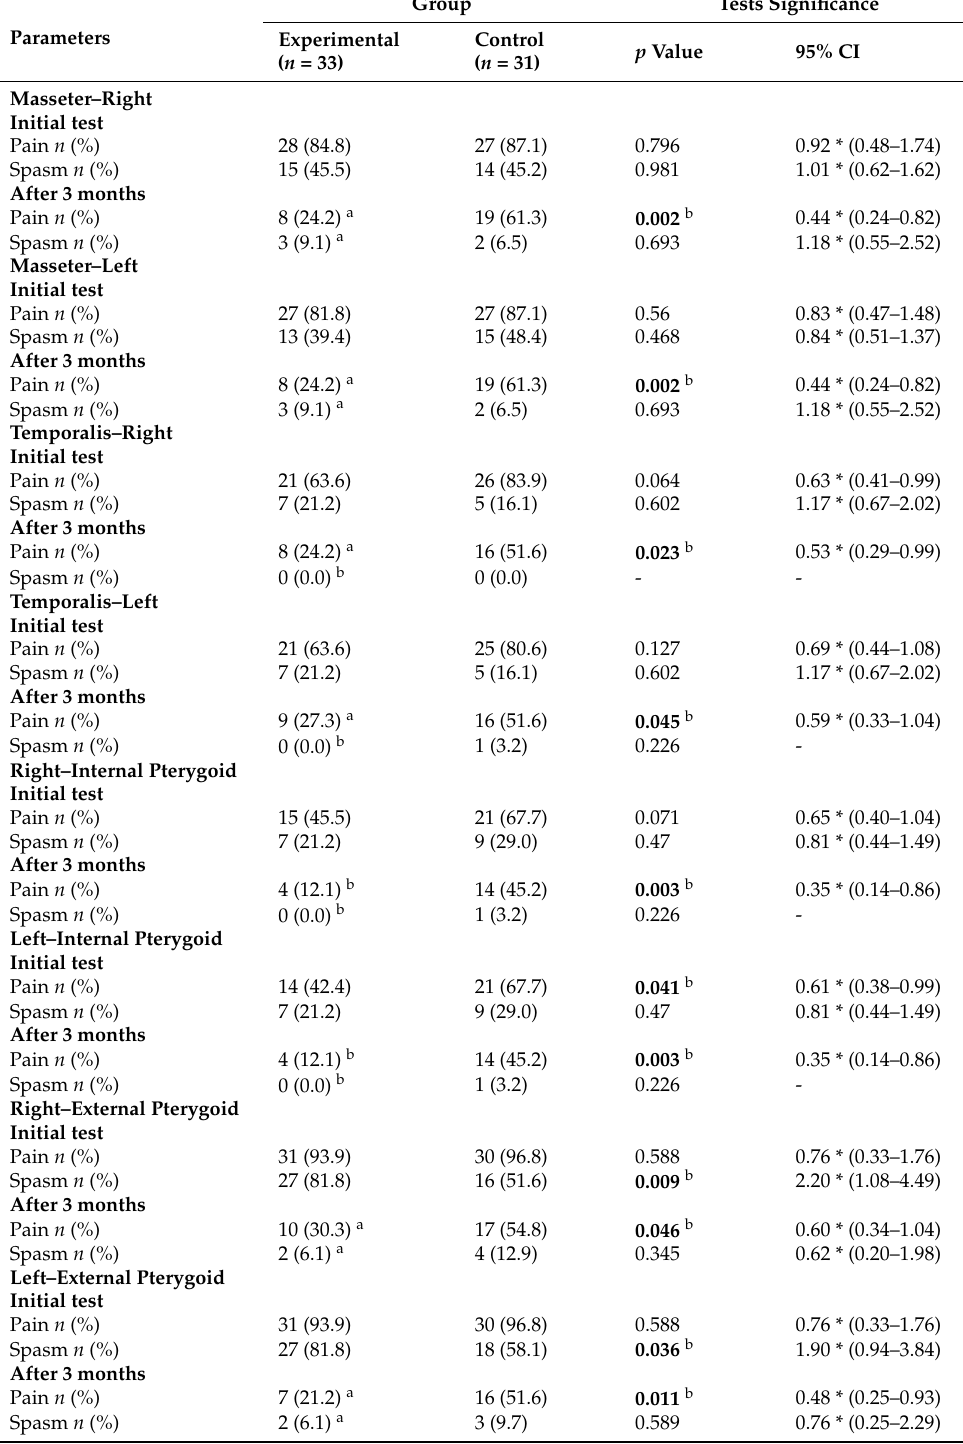
Table 4. Temporomandibular muscle